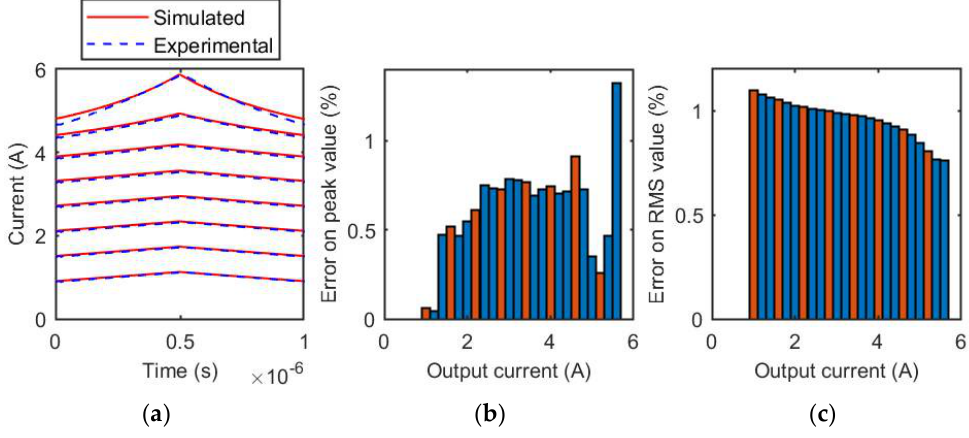
Figure 9. Coilcraft MSS1260T-273 inductor, 1 MHz. ( a ) Comparison of experimental and simulated current waveforms for different output current values; ( b ) relative error of the estimation of the peak value of the inductive current for each tested output current value. The orange bars represent the test cases reported in ( a ), the blue bars are related to the other measurements of the evaluated current range; ( c ) relative error of the estimation of the RMS value of the inductive current, for each tested output current value. The orange bars represent the test cases reported in ( a ), the blue bars are related to the other measurements of the evaluated current range.